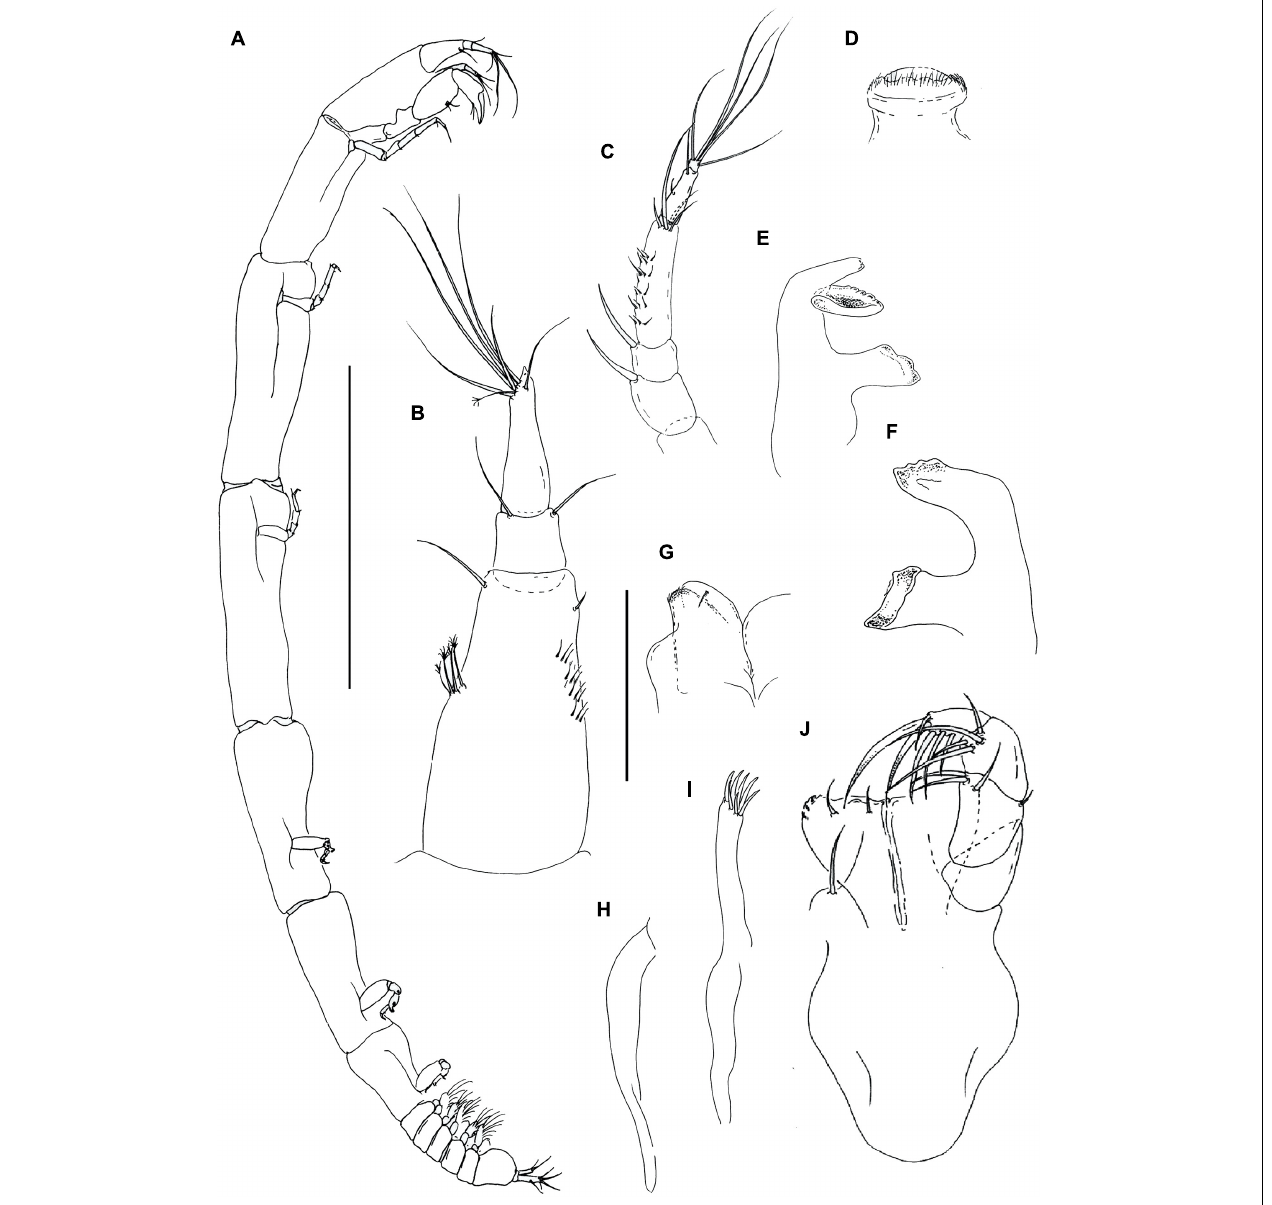
FIGURE 11 | Rakaduta inexcessis n. sp. (J57983) (A) neuter; (B) antennule; (C) antenna; (D) labrum; (E,F) mandible left and right, respectively; (G) labium; (H) epignath; (I) maxillule endite and palp; (J) maxilliped. Scale: panel (A) = 1 mm, panels (B–J) = 0.1 mm.